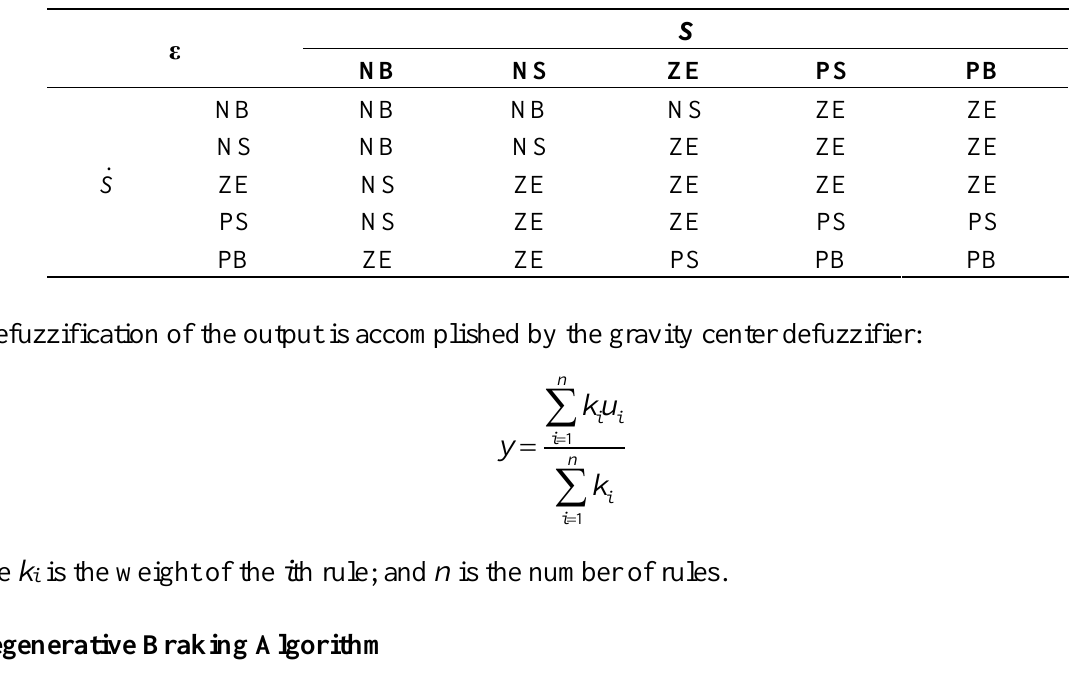
Table 2. Rules of the fuzzy logic controller. NB, NS, ZE, PM and PB mean negative big, negative small, zero, positive small and positive big,